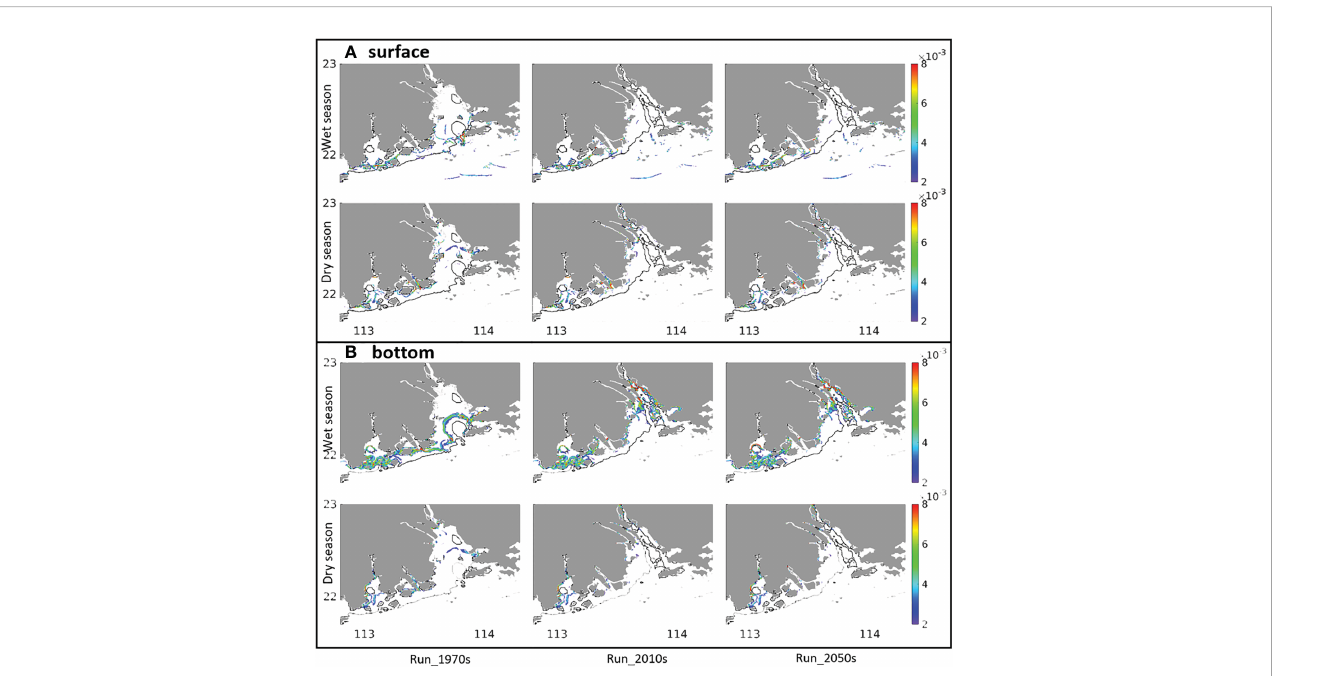
FIGURE 7 Location of estuarine fronts in the (A) surface and (B) bottom water (identi fi ed by salinity gradient greater than 0.0015 psu/m) in the PRE in the three scenarios. The black line indicates the 7-m isobaths. (Unit: psu/m). Supplementary Material provides a zoom in view of Lingding Bay (Supplementary Figure